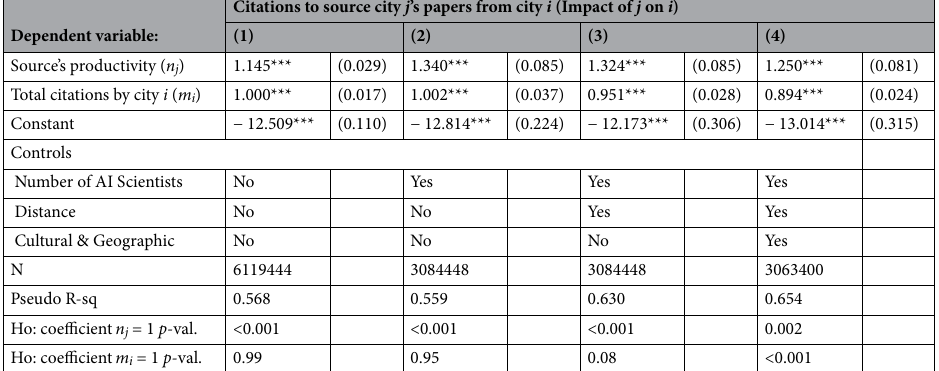
Table 1. Gravity model: citations. The table shows the estimation of the Poisson Pseudo-Maximum Likelihood estimation of the gravity model of citations. Column (1) shows the point estimates of the baseline frictionless model as benchmark. The remaining columns present the estimates of models with frictions as controls added sequentially. The number of observations decreases after including controls because of missing observations on the number of scientists, and cultural-geographic variables. The last two rows show the p -values associated with a one degree-of-freedom chi-squared test where the null hypothesis is the corresponding coefficient being equal to 1. The Table with all the estimates is in Supplementary Table 2. Standard errors are in parentheses to the right of each coefficient. Stars next to each estimate denote significance at conventional levels (* p -value